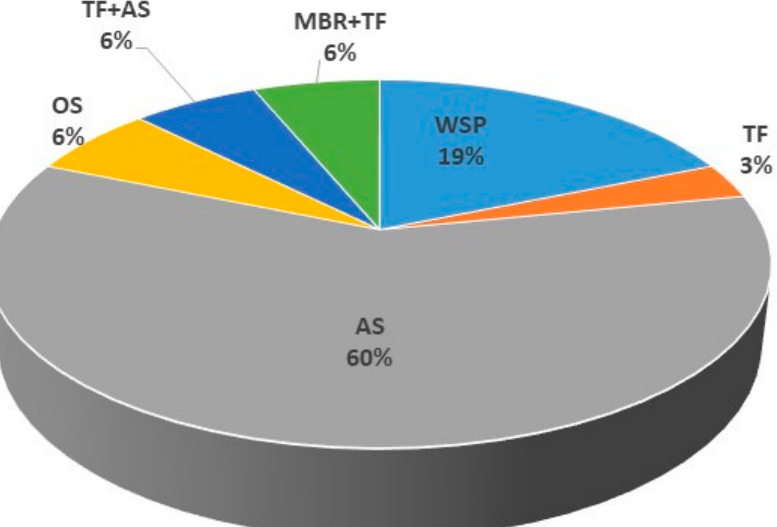
Figure 2. The variety and distribution of different processes in wastewater treatment plants (WWTPs) in Jordan. AS stands for activation sludge; OS is oxidation sludge; TF is trickling filter; WSP is wastewater stabilization pond; MBR + TF is Membrane Bioreactor and TF process; and TS + AS is trickling filter and activation sludge process.